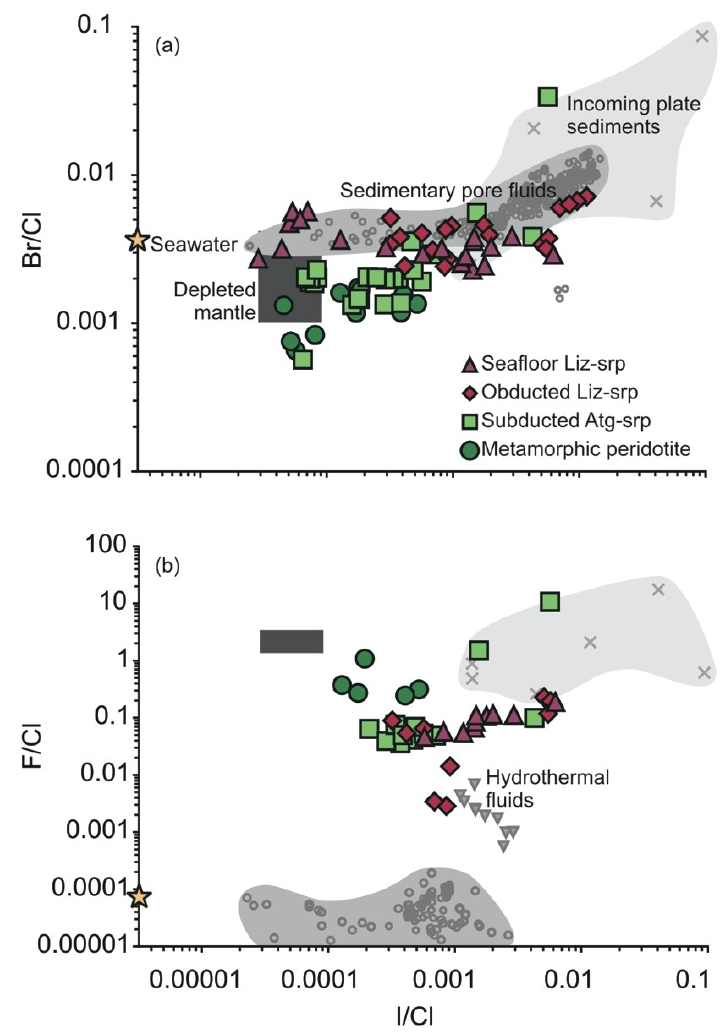
Figure 4. Halogen ratios of seafloor and obducted abyssal lizardite serpentinites (Liz srp), subducted antigorite serpentinites (Atg srp) and metamorphic peridotites after serpentinite dehydration. Bulk serpentinite data are from [43,44,48,53]. ( a ) Br/Cl and I/Cl ratios of the seafloor and obducted abyssal serpentinites overlap with those of sedimentary pore fluids (see [24] for review), while the Br/Cl ratios of the subducted serpentinites and metamorphic peridotites extend to lower values, similar to the depleted mantle [6]. ( b ) F/Cl ratios of all serpentinites are much higher than seawater [54], suggesting input from F-rich hydrothermal fluids (e.g., Escanaba Trough high 3 He/ 4 He pore fluids) [56] on the seafloor, or F mobilized from incoming plate sediments [53] and igneous lithologies during shallow subduction. On average, the subducted antigorite serpentinites and metamorphic peridotites have higher F/Cl ratios relative to their lizardite-bearing counterparts.